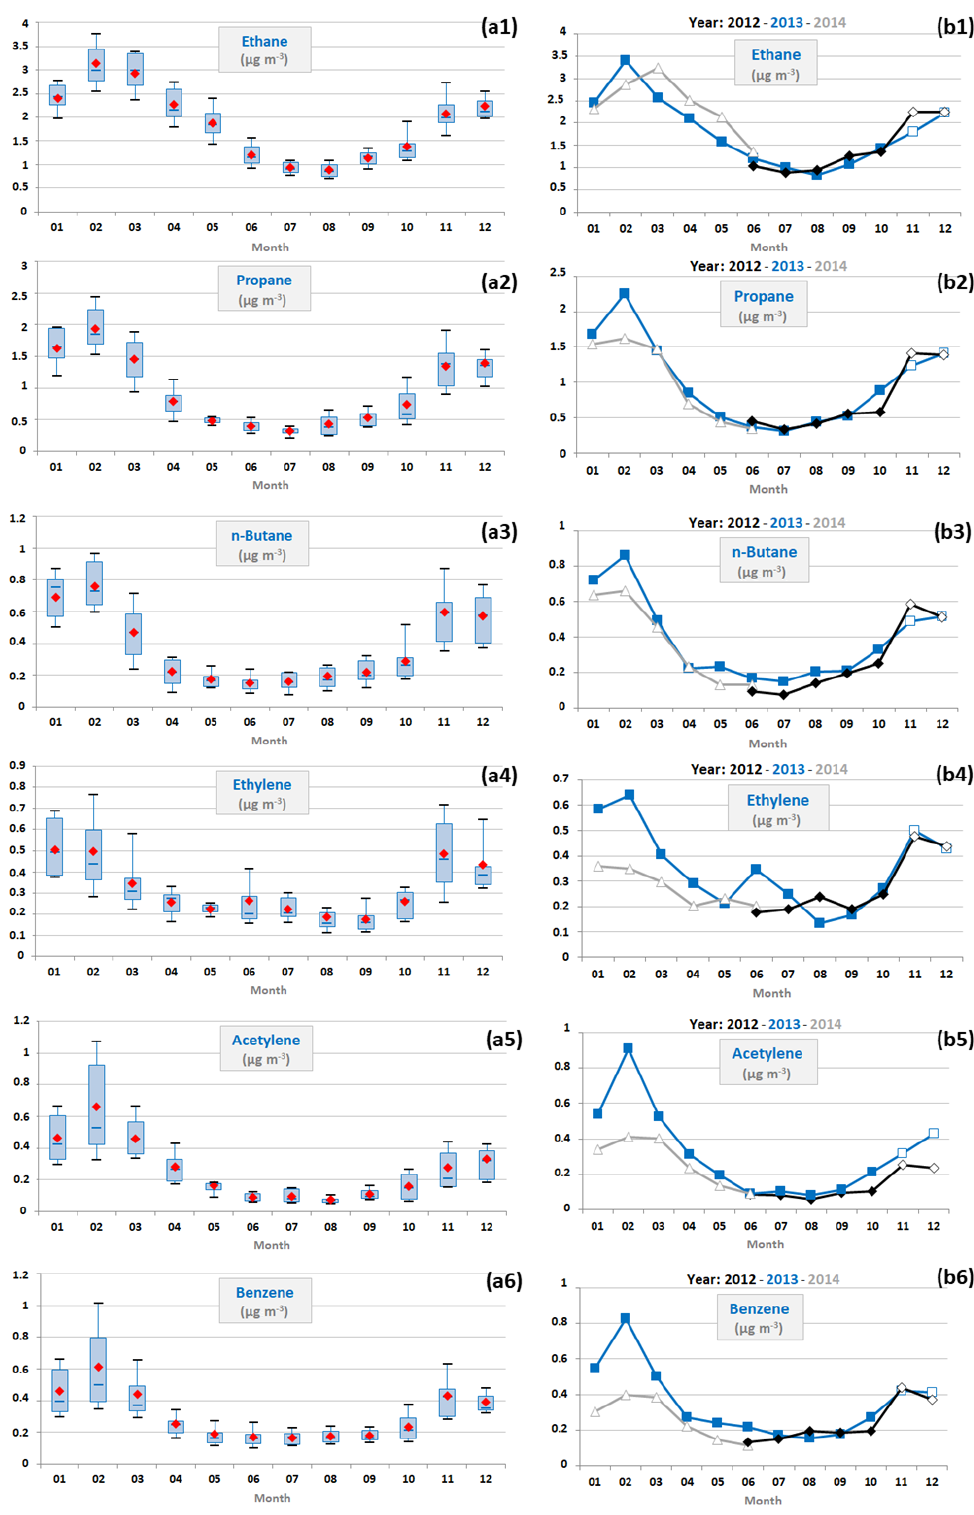
Figure 5. (a) Monthly variations in a selection of anthropogenic VOC concentrations (expressed in µgm − 3 ) represented by box plots; the blue solid line, the red marker, and the box represent the median, the mean, and the interquartile range of the values, respectively. The bottom and top of the box depict the first and third quartiles and the ends of the whiskers correspond to the first and ninth deciles. (b) Their monthly average concentrations as a function of the year; full markers indicate months when VOC samples were collected from 12:00 to 16:00UTC and empty markers those when VOC samples were collected from 09:00 to